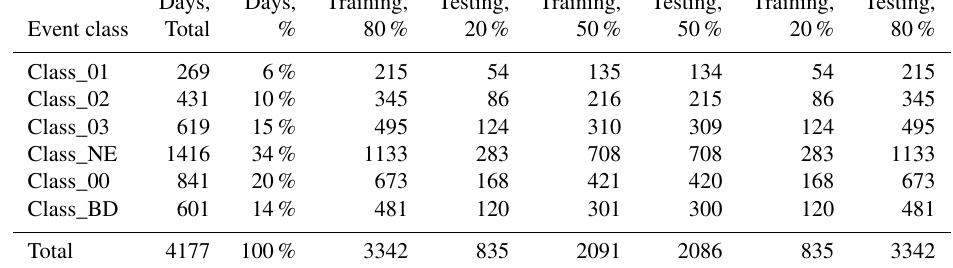
Table 1. Summary of the number of days in different NPF event classes based on manual classification and division of days to three different